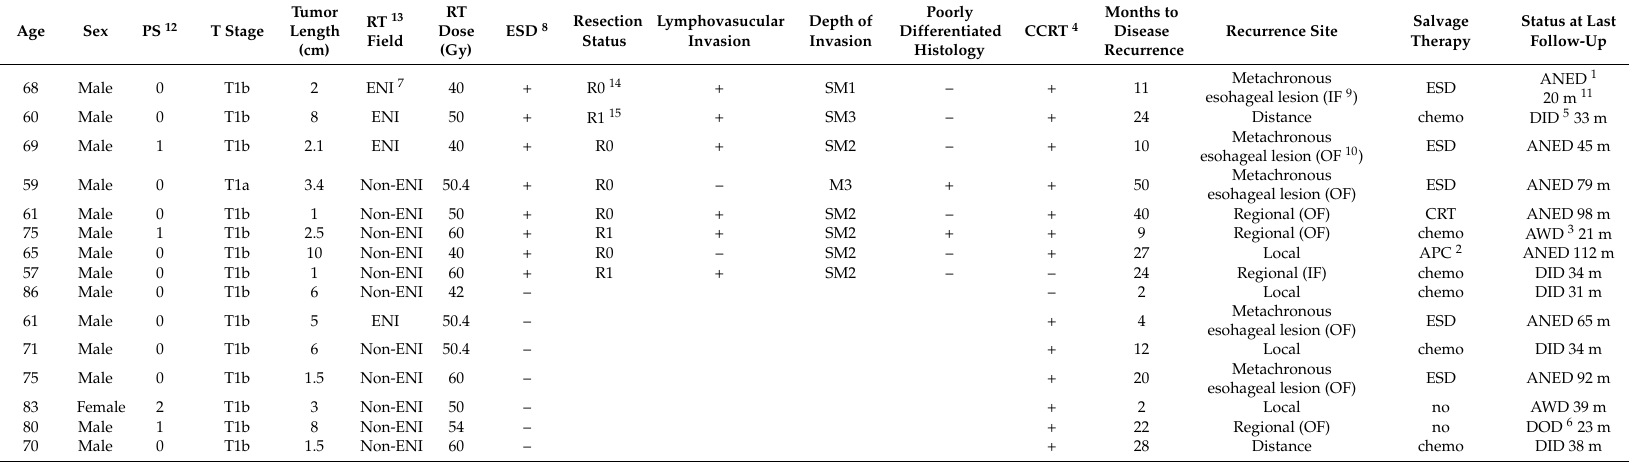
Table 3. The summary of recurrent